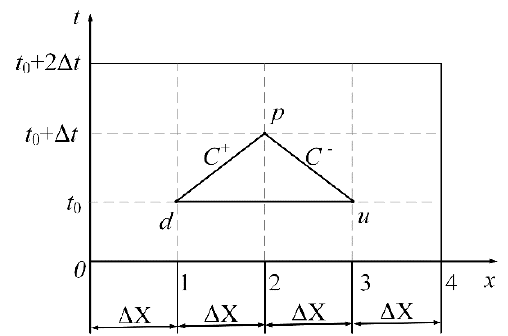
Figure 3. The schematic diagram of MOC.